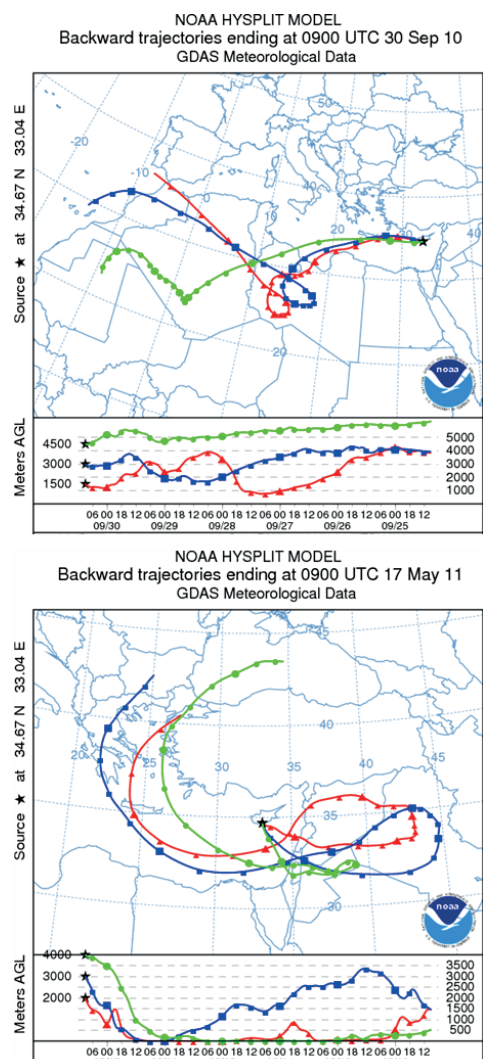
Figure 4. 6-day HYSPLIT backward trajectories arriving at Limas- sol, Cyprus, at 1500m (red, top) and 2000m (red, bottom), 3000m (blue), 4000m (green, bottom), and 4500m height (green, top) on 30 September 2010, 09:00UTC (top) and 17 May 2011, 09:00UTC